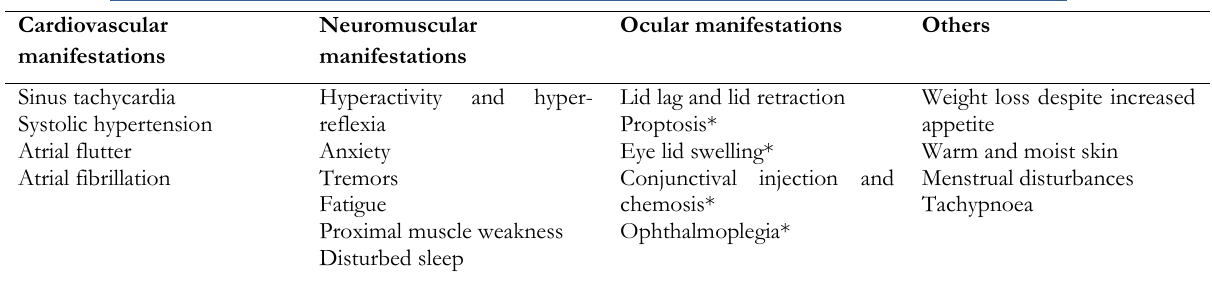
Table 3.3. Common clinical presentations of